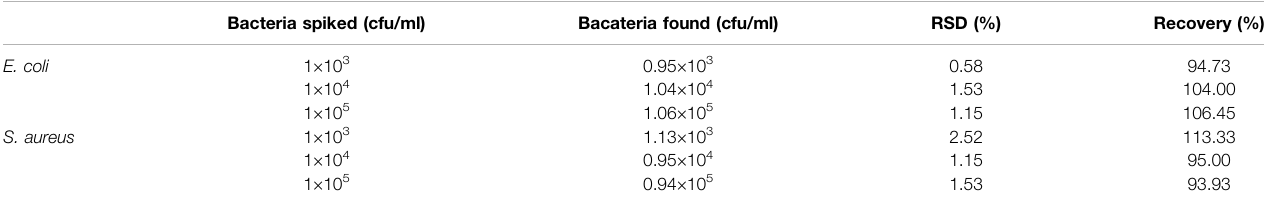
TABLE 1 | Recovery tests of E. coli and S. aureus in tap water ( n (cid:1) 3). Bacteria spiked (cfu/ml)